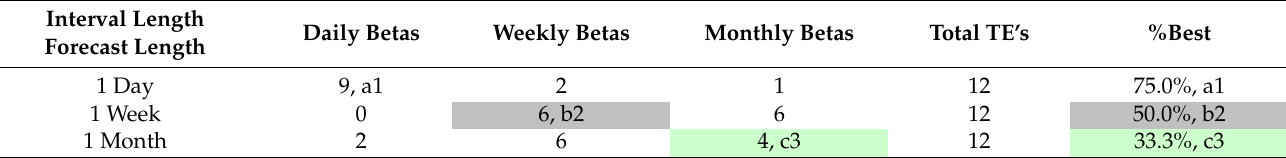
Table 2. 3 × 3 Classification Matrix of ’Minimum’ Tracking Errors.